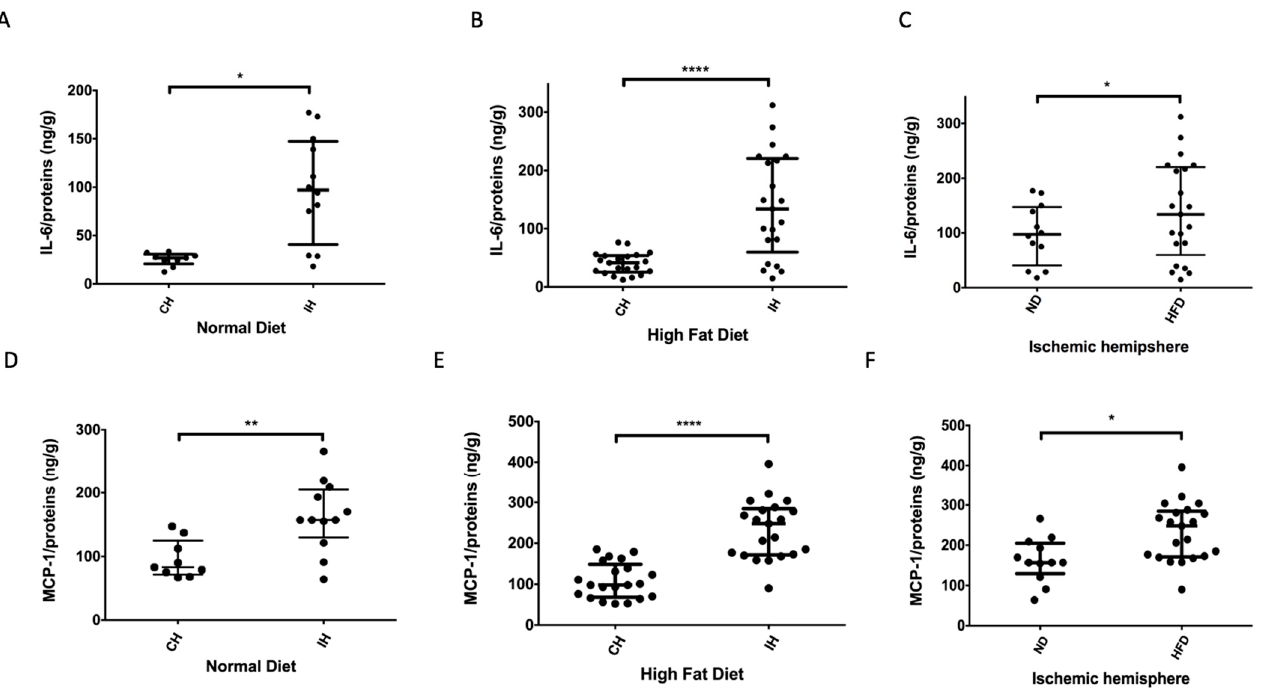
Figure 5. Brain IL-6 and MCP-1 quantification. ( A ) Under normal diet (ND), there is statistically significant IL-6 increase in ischemic hemisphere (IH) relative to contralateral hemisphere (CH) n = 12; * p = 0.039. ( B ) Under HFD, brain IL-6 level is increased in IH vs. CH ( n = 21); **** p < 0.0001. ( C ) Significant difference was observed for IL-6 comparing IH in HFD and ND conditions, ND n = 12 and HFD n = 21; * p = 0.019. ( D , E ) Increased in brain MCP-1 level in IH vs. CH was statistically significant in ND n = 12; ** p = 0.003 and in HFD conditions, HFD n = 21; **** p < 0.0001. ( F ) The increase in MCP-1 level observed in the IH is significantly more important in the HFD group ( n = 21) relative to the ND group ( n = 12); * p = 0.023.